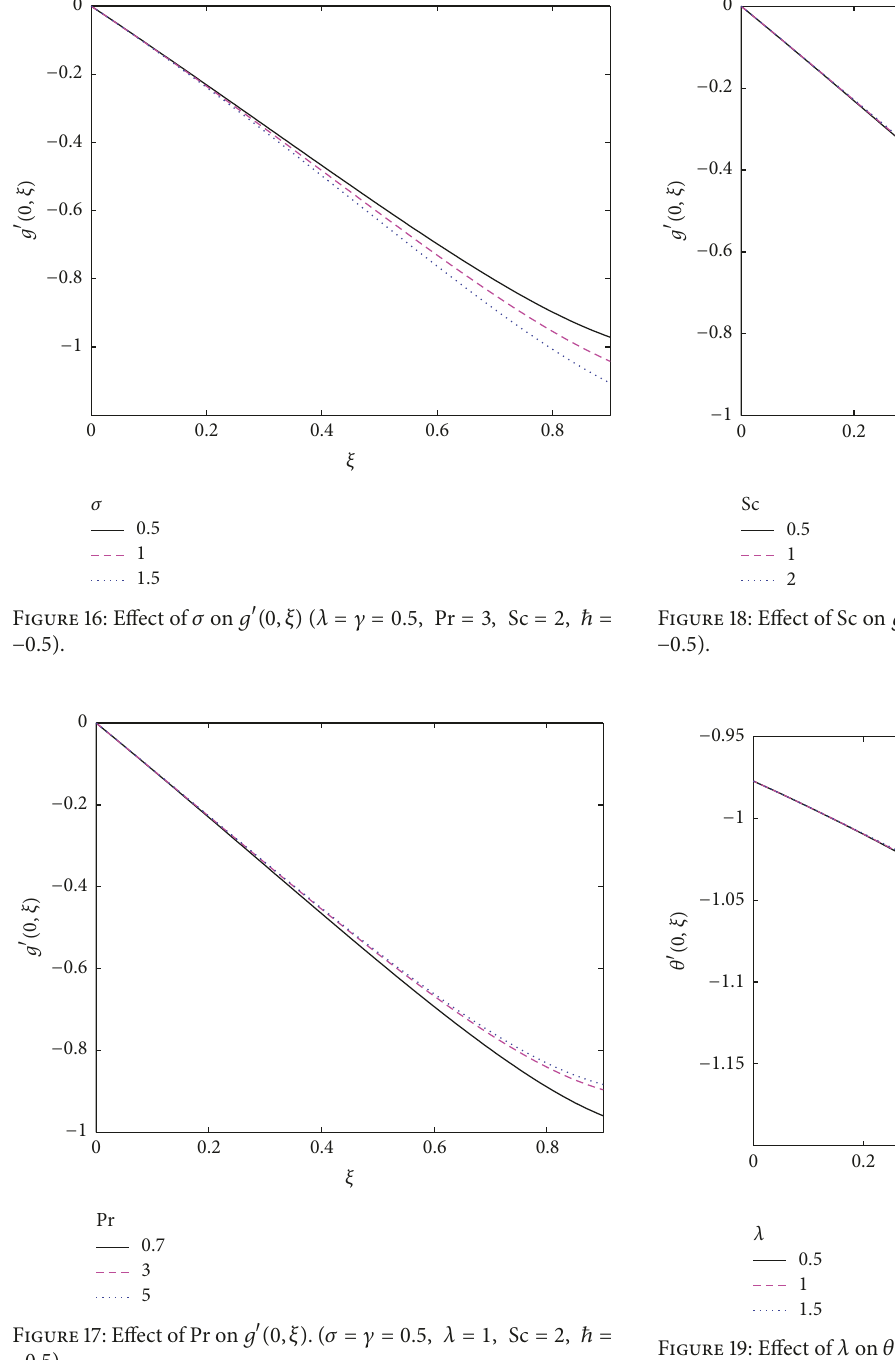
Figure 19: Effect of 𝜆 on 𝜃 󸀠 (0, 𝜉) ( 𝜎 = 𝛾 = 0.5, Pr = 3, Sc = 2, ℏ = −0.5